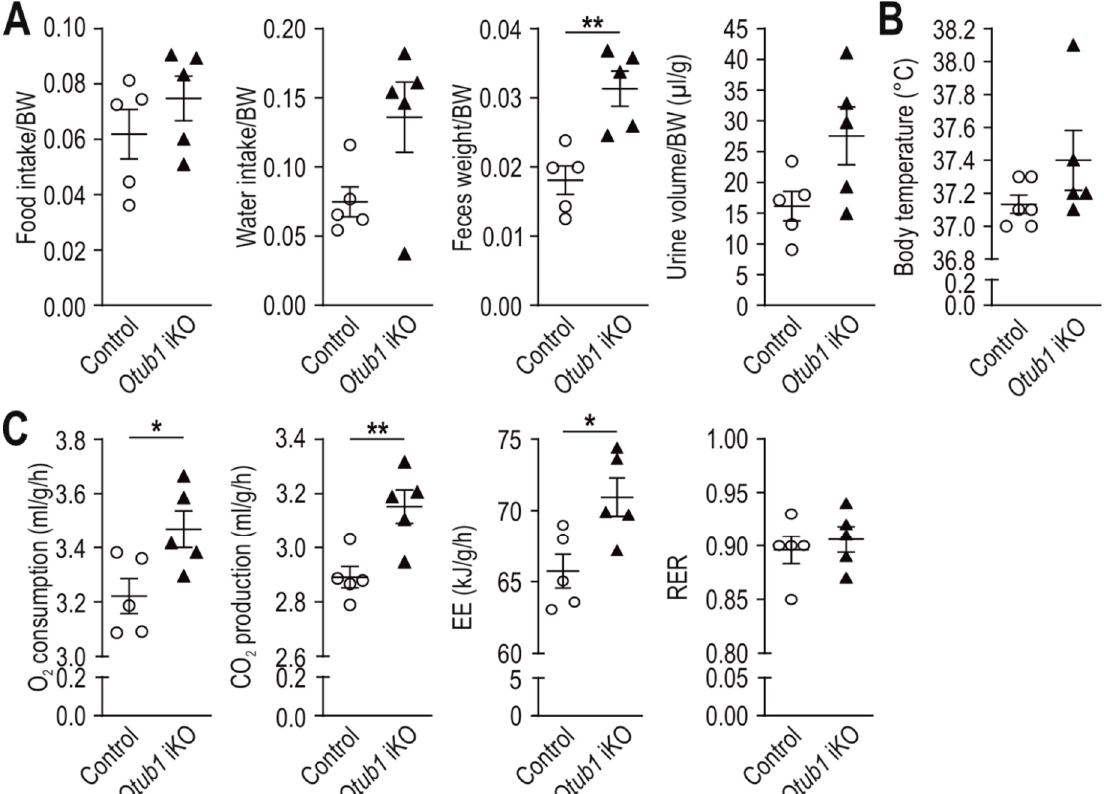
Figure 2. Energy metabolism in Otub1 iKO mice. ( A ) Analysis of food and water intake, feces weight and urine volume over 72 h (4.5 months after Otub1 KO; 6-month-old mice, n = 5). ( B ) Rectal body temperature (2.5 months after Otub1 deletion; 5-month-old mice; control, n = 6; Otub1 iKO, n = 5). ( C ) O 2 consumption, CO 2 production, energy expenditure (EE) and respiratory exchange ratio (RER) of 3 consecutive days during the light cycle (5 months after Otub1 deletion; 6.5-month-old mice; n = 5). All data are presented as the mean ± SEM. *, p < 0.05; **, p < 0.01 by two-tailed Student’s t -test.